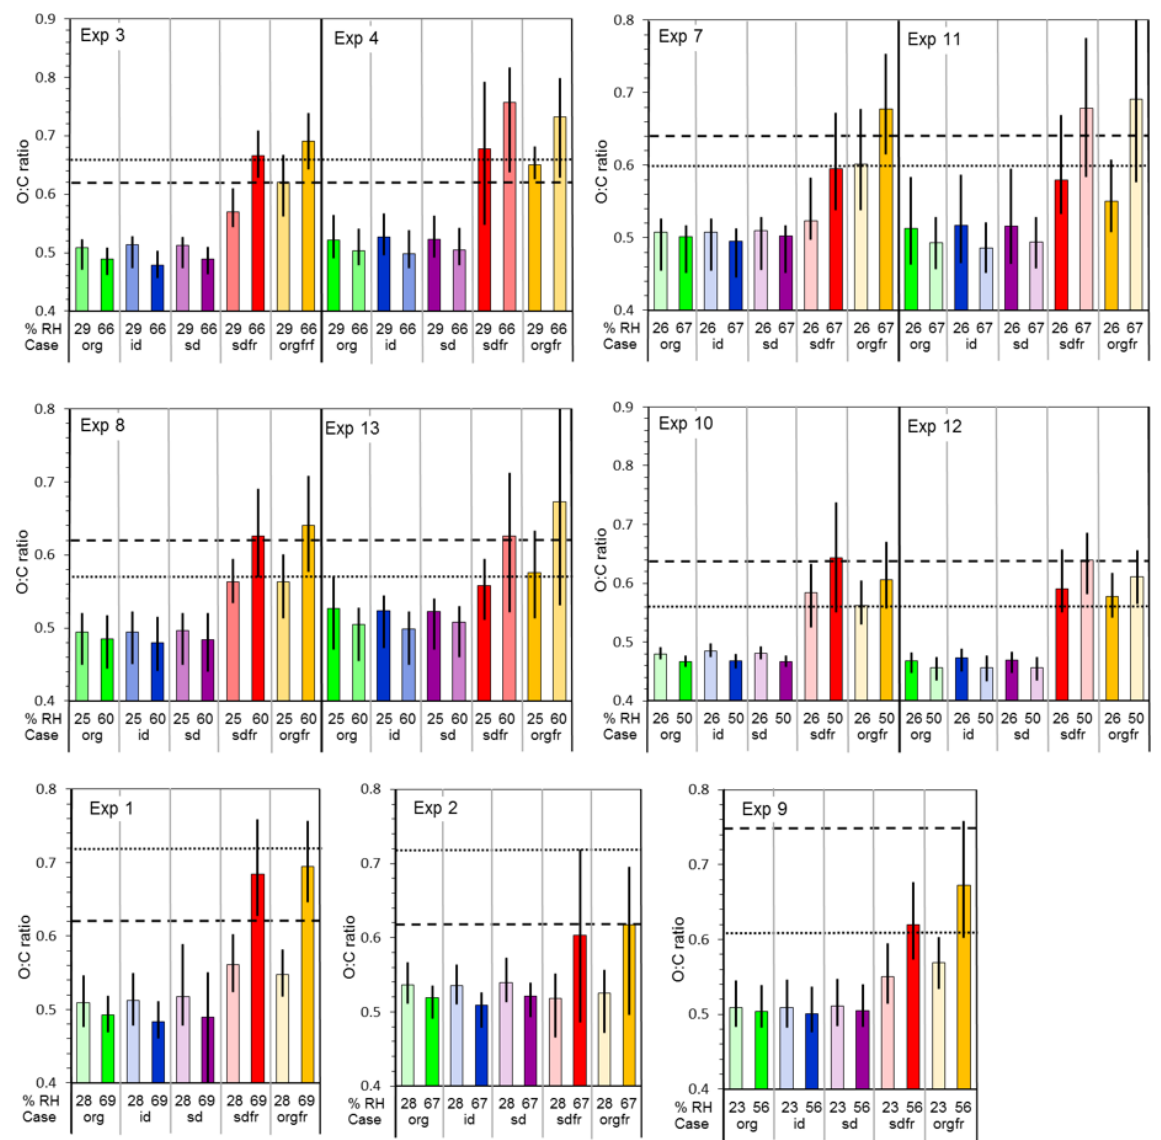
Figure 8. Calculated average O:C ratios for experiments at the measured RH (columns in full colours) and at the RH of the corresponding experiments (light colours; see Table 2 for reference) based on 10 randomly chosen volatility distributions for the cases org, id, sd, sdfr, and orgfr (identified by different colours). The vertical black lines in the columns indicate the range of values obtained for the calculations with the individual volatility distributions. The horizontal dotted line marks the measured value for the experiment performed at low RH, the dashed line the value for the experiment performed at high